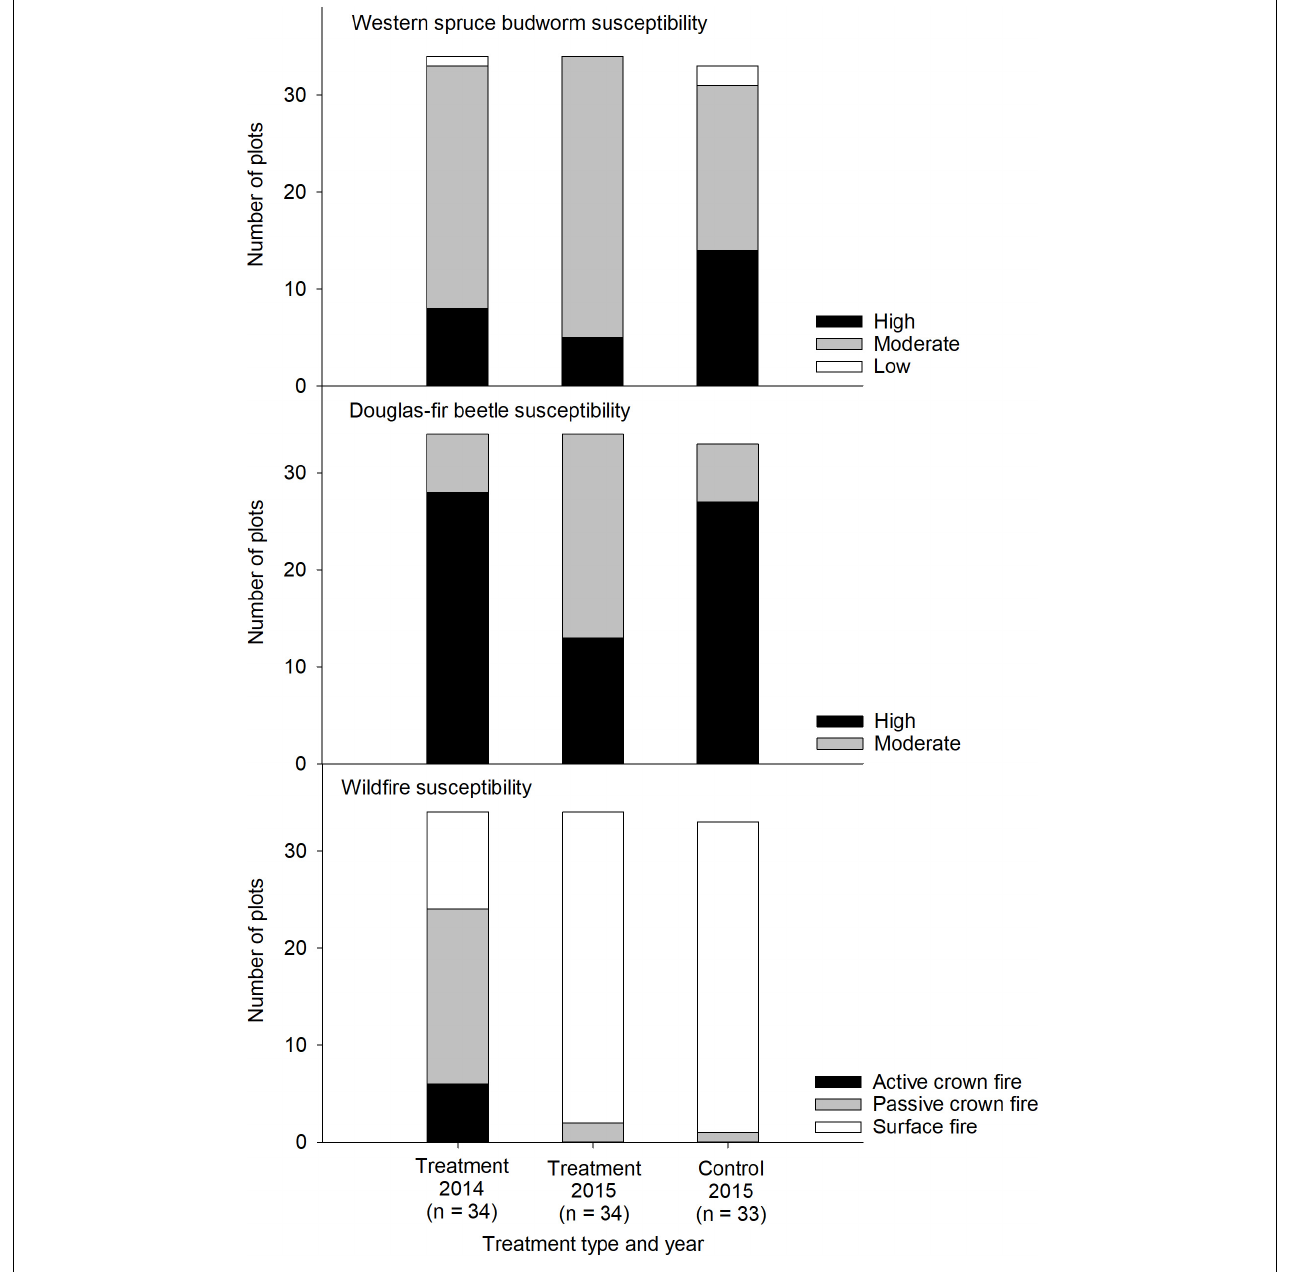
FIGURE 2 | Susceptibility to biotic and abiotic disturbances following a harvesting treatment to enhance mule deer winter habitat. Treatment plots were sampled in 2014 and 2015; control plots were sampled in 2015